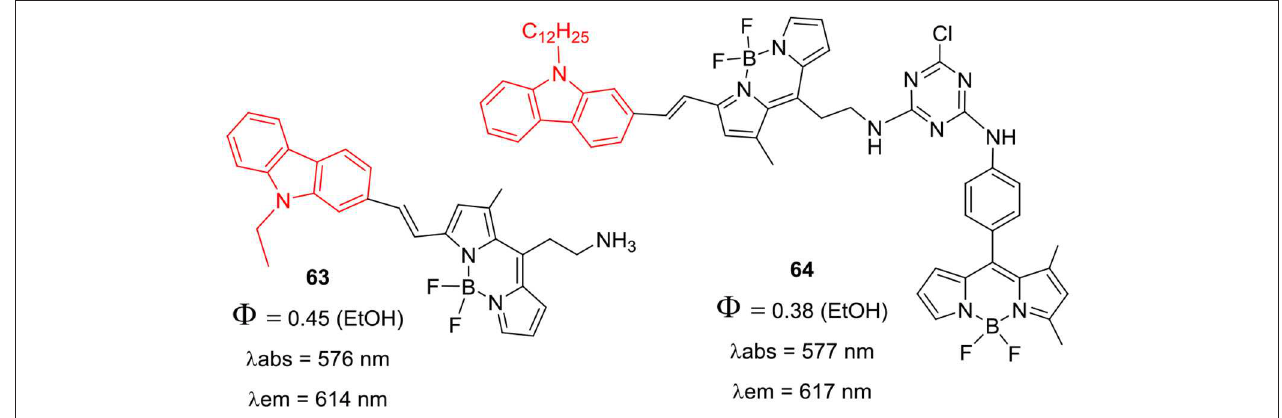
CHART 4 | Carbazole-BODIPY based systems for